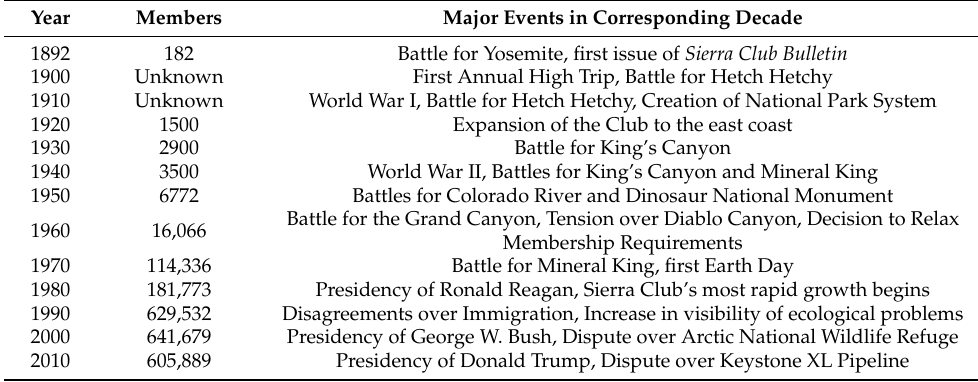
Table 1. Number of Sierra Club Members at the Start of Each Decade 1 .